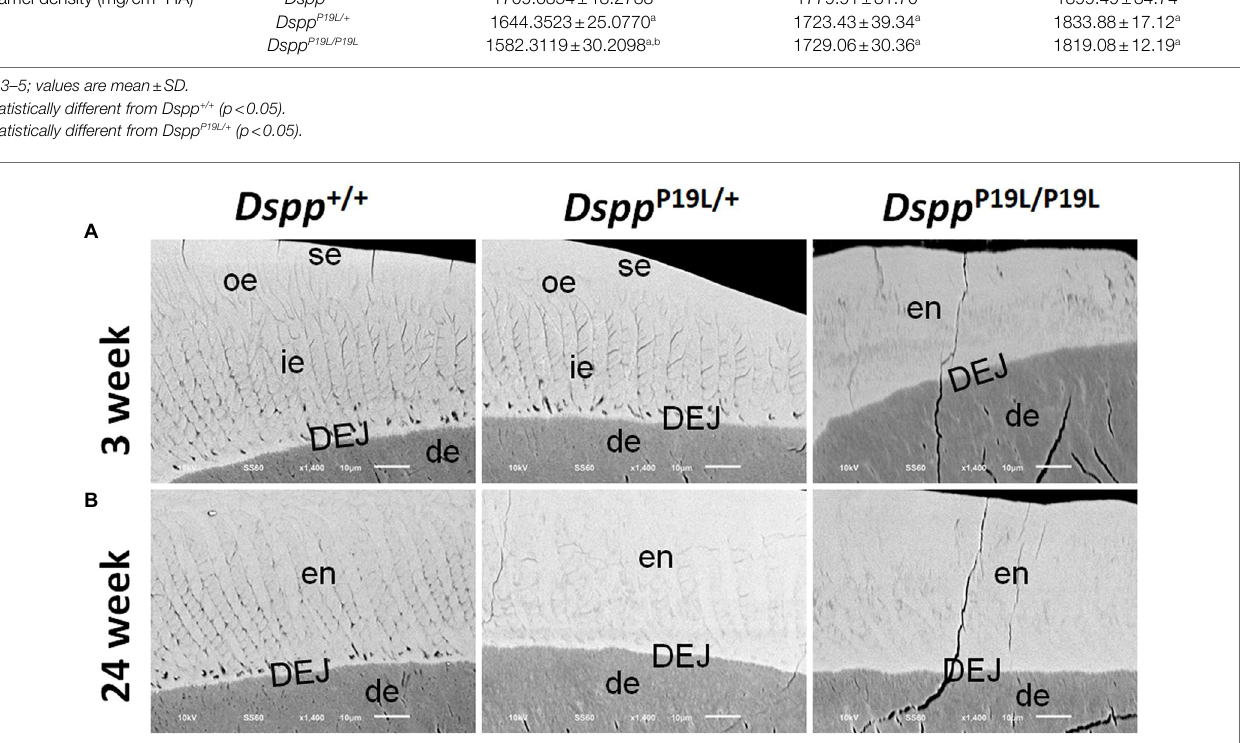
FIGURE 4 | Backscattered SEM analyses of the mandibular first molars. Shown are the backscattered SEM images of the mandibular first molars of 3- (A) and 24- (B) week-old wild-type Dspp +/+ , heterozygous Dspp P19L/+ and homozygous Dspp P19L/P19L mice. All images are the longitudinal sections and buccal sides of the mandibular first molars. Three-week-old Dspp +/+ mice showed a decussating pattern of enamel rods in the inner enamel (ie), a parallel pattern in the outer enamel (ore), and were rod-free in the superficial enamel (se). Three-week-old Dspp P19L/+ mice showed a similar arrangement of enamel rods as the age-matched wild-type mice, but there were no discernable enamel rods in 3-week-old Dspp P19L/P19L mice. By 24 weeks, the decussating enamel rods remain in Dspp +/+ mice. However, the enamel rod boundaries became blurred in Dspp P19L/+ mice, whereas only poorly-defined enamel rods were observed in Dspp P19L/P19L mice. ie, inner enamel; oe,